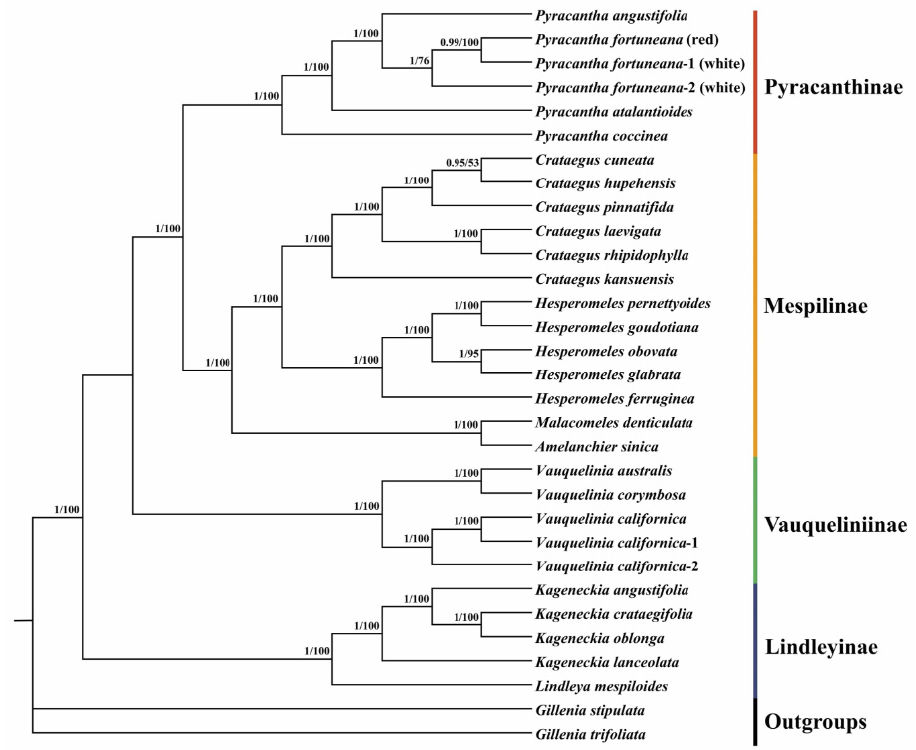
Figure 9. The phylogenetic tree of the genus Pyracantha inferred from chloroplast genome sequences based on the methods of maximum likelihood (ML) and Bayesian inference (BI). The BI posterior probabilities/ML bootstrap values are displayed above the lines.